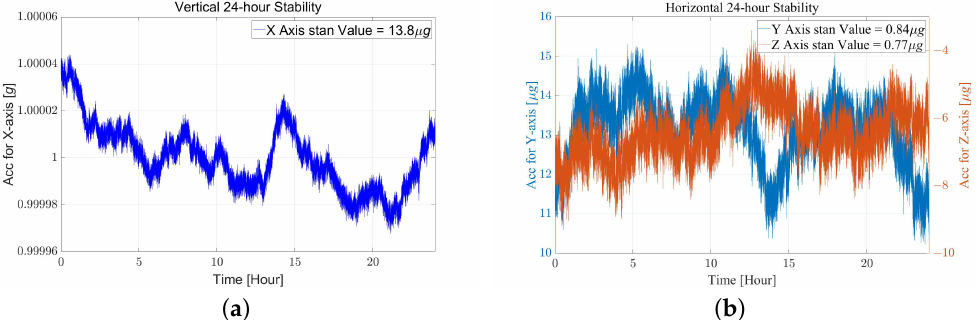
Figure 9. The 24-h bias stability test of the prototype with a gravitational loading of ( a ) vertical 1-g and ( b ) Horizontal 0-g, which is about 13.8 µ g (X), 0.84 µ g (Y), and 0.77 µ g (Z), respectively.